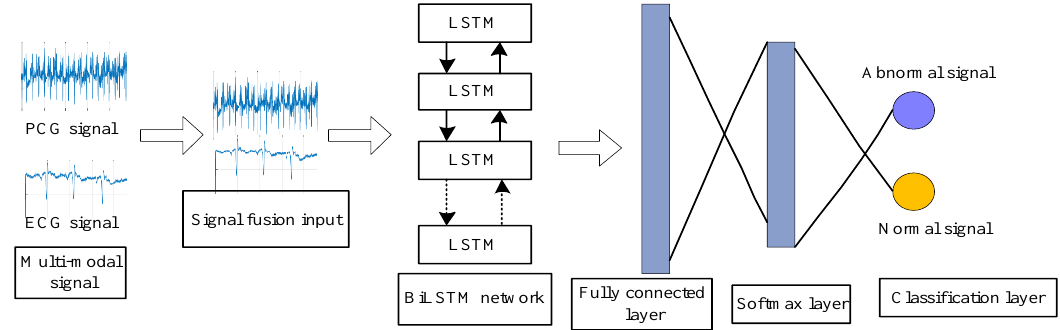
Figure 9. BiLSTM network structure.